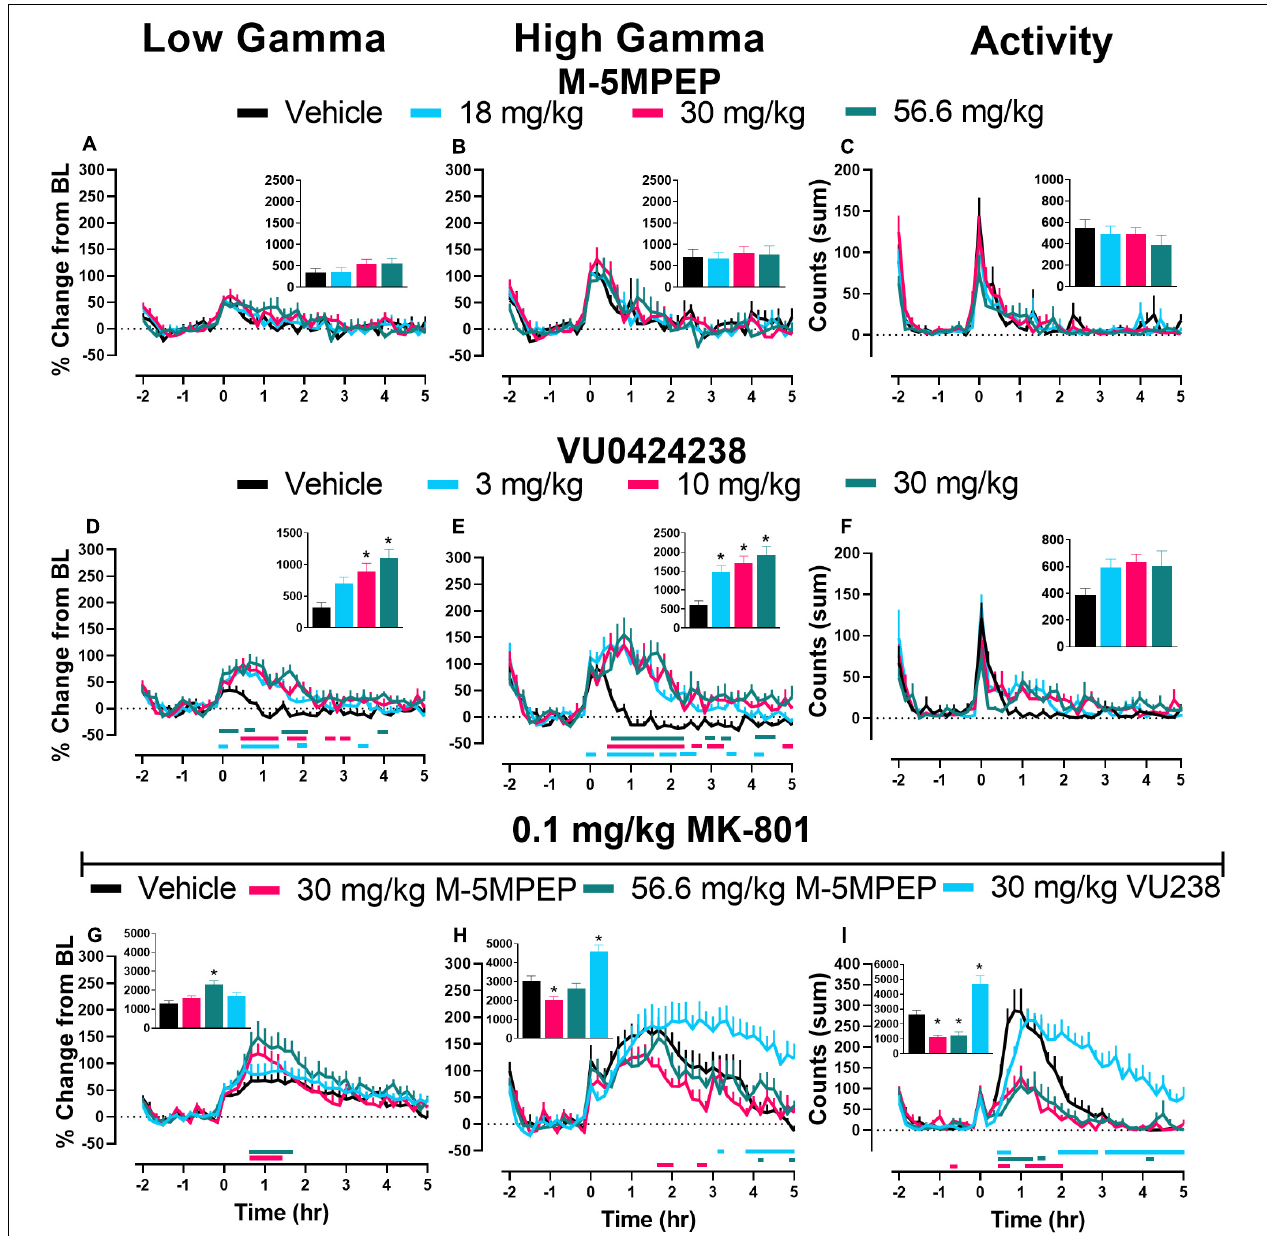
FIGURE 5 | VU0424238, but not M-5MPEP, increased gamma power and potentiated MK-801-induced elevations. Data shown are group means ± SEM ( n = 8) presented in 10 min bins for effects of M-5MPEP (A–C) , VU0424238 (D–F), and combinations with 0.1 mg/kg MK-801 (G–I) on low (A,D,G) and high frequency (B,E,H) gamma power and activity (C,F,I) . qEEG gamma power is expressed as a percent change from the average of each individuals’ 90-min baseline just prior to compound administration. Activity is expressed as summed counts in 10 min bins. Insets represent area under the curve (AUC) from time points 0–5 h post administration (A,B,D,E,G,H) or sum of all activity (C,F,I) . M-5MPEP and VU0424238 were administered at time point 0; Vehicle or MK-801 were administered 30 minutes after administration of mGlu 5 NAMs. Time point -2 corresponds to ZT 0 and time point 5 corresponds to ZT 7. Horizontal colored lines represent